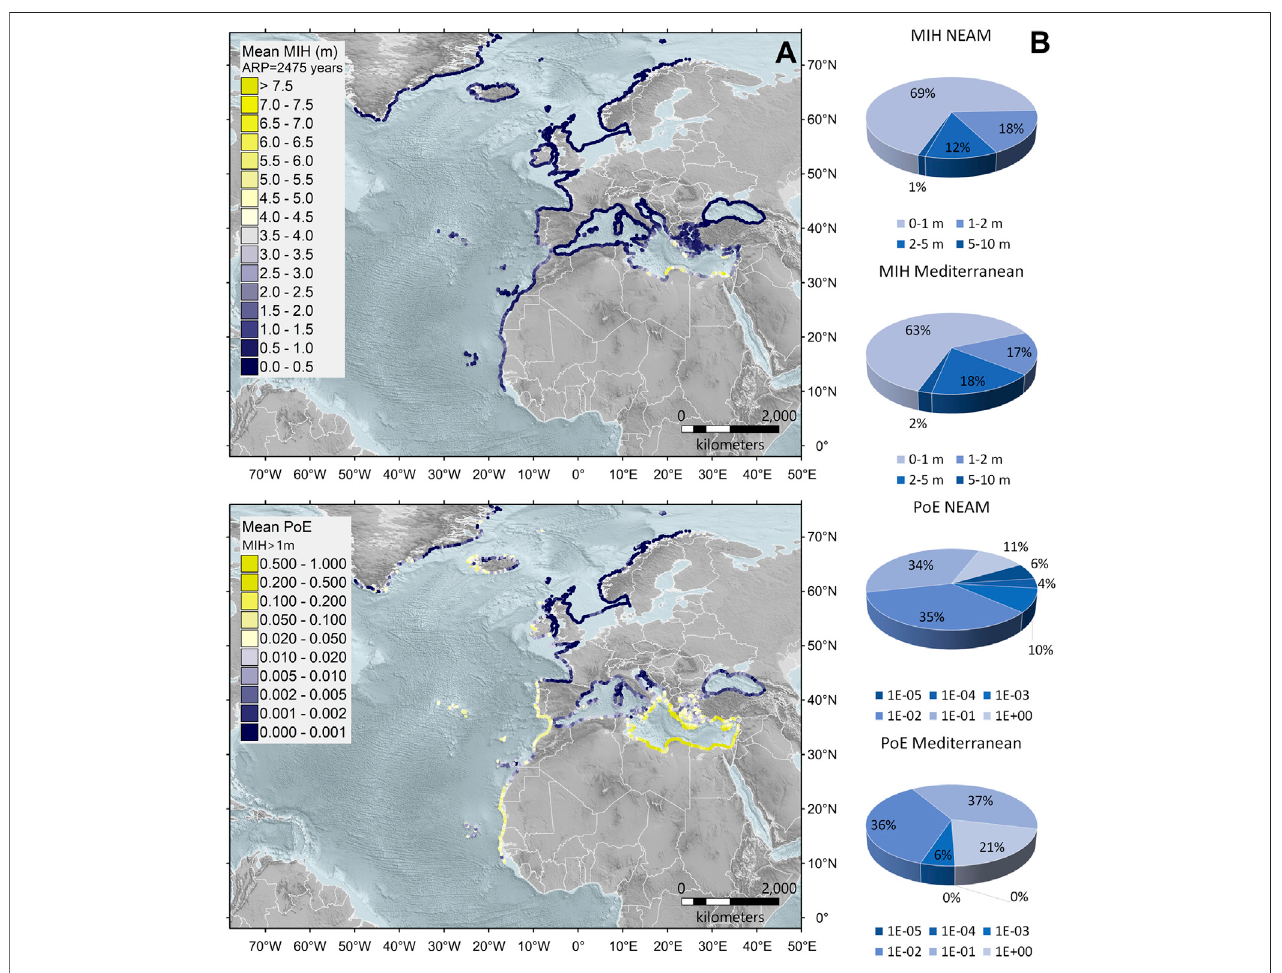
FIGURE11|(A) NEAMTHM18hazard mapfortheprobabilityofexceedance of2%in50 years, equivalent toanaveragereturnperiod of2,475 years (upper) and NEAMTHM18probabilitymapformaximuminundationheightlargerthan1 m (lower) .Topo-bathymetryisfromtheETOPO1GlobalReliefModel(NOAA,2009;Amante and Eakins, 2009). (B) Pie charts showing the percentage of points of interest in the NEAM and Mediterranean coastlines that correspond to different maximum inundation heights for an average return period of 2,475 years (two upper charts) and to different probabilities of exceedance of a maximum inundation height of 1 m (two lower charts) . Notice the increasing proportion of points of interest with higher hazard in the Mediterranean region relative to the entire NEAM Region.